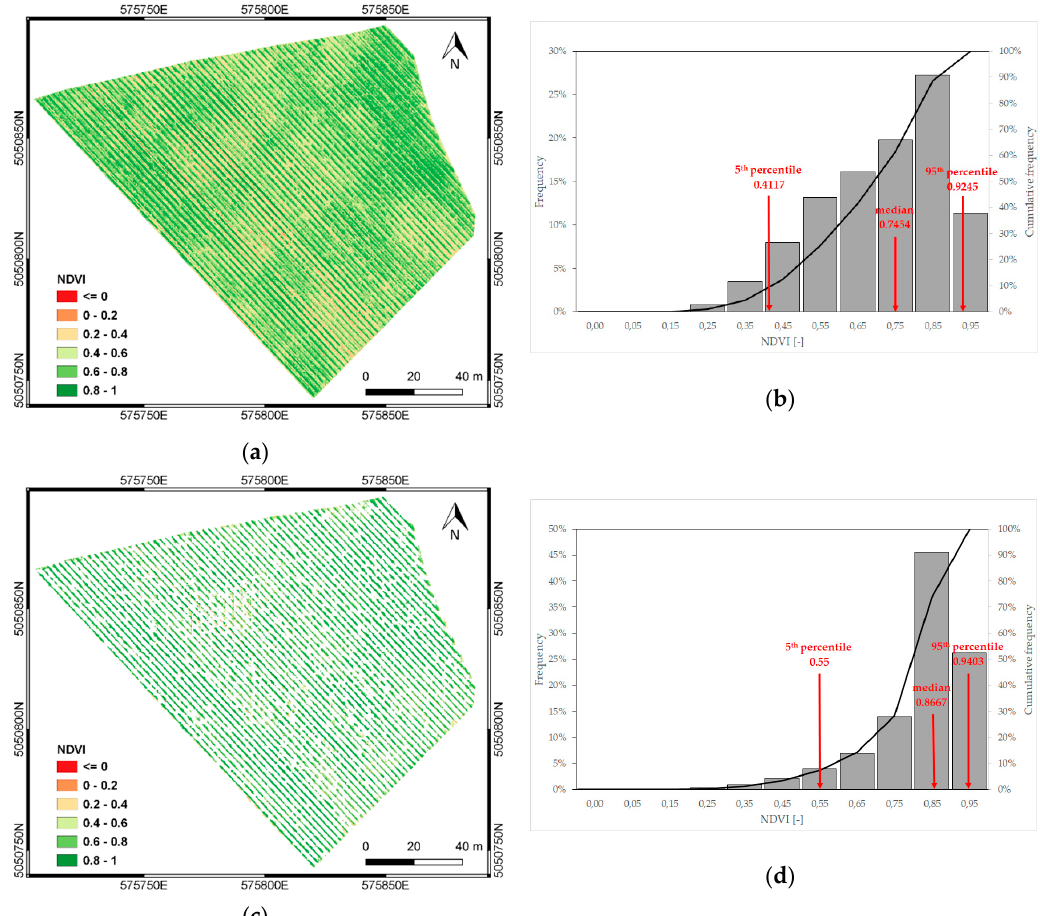
Figure 7. Slope map and contour lines derived from the DTM.